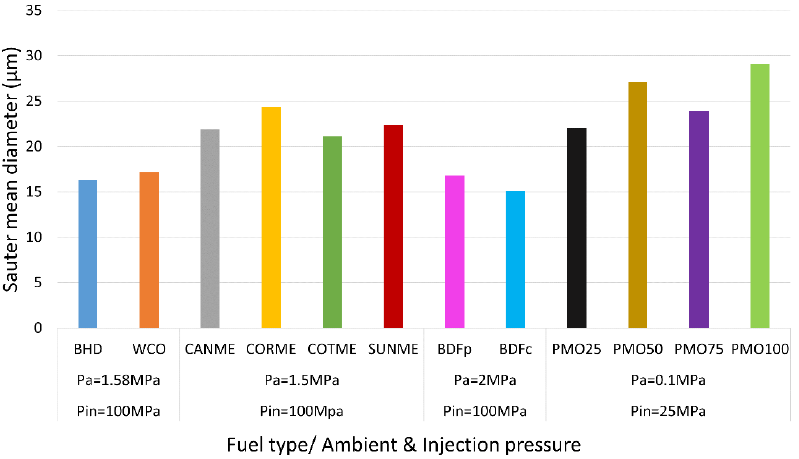
Figure 12. Spray cone angle for various biodiesel blends at different injection & ambient pressures [47,87,92,94,99].